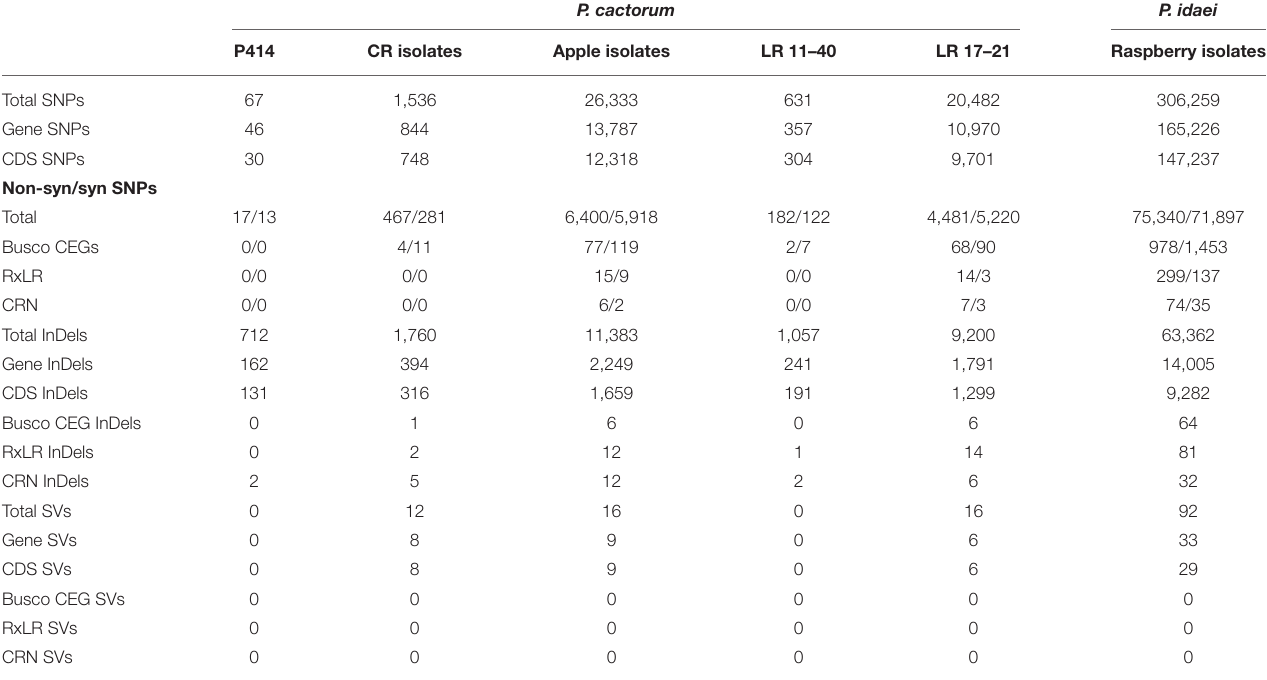
TABLE 4 | Variant calls vs. the reference P414 genome.